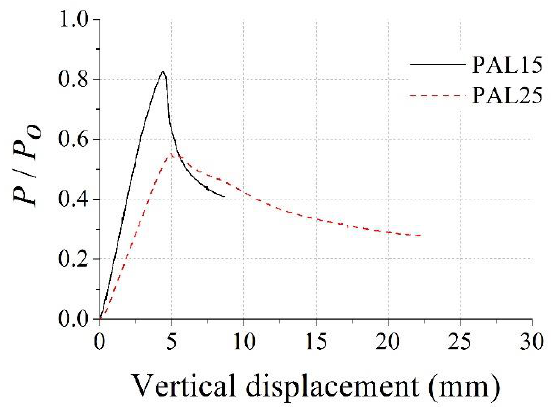
Figure 8. Dimensionless axial load vs. vertical displacement for PAL15 and PAL25.